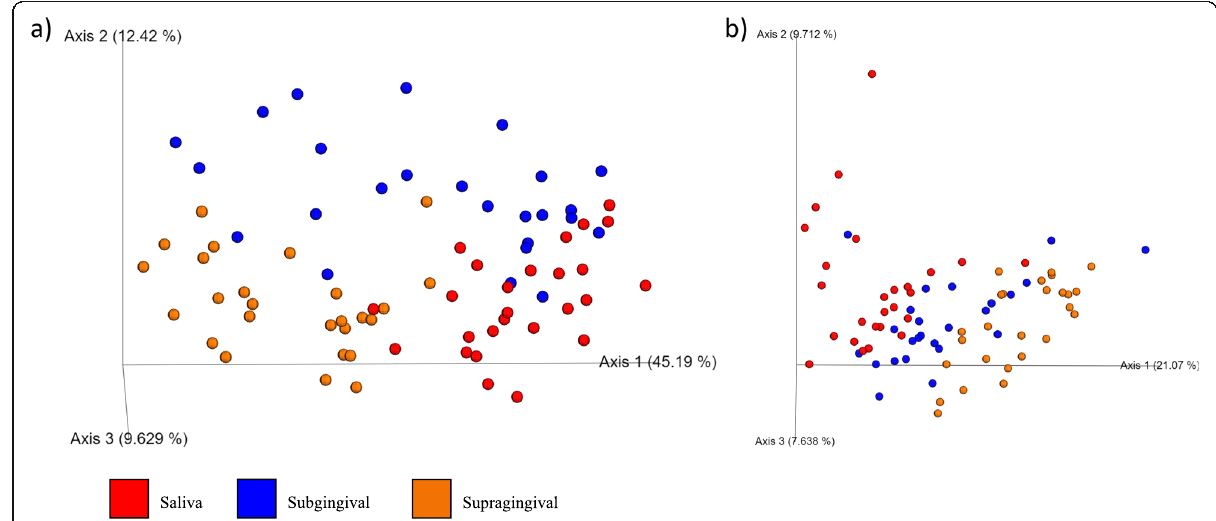
Fig. 2 Principal coordinates analysis (PCoA) plots of weighted ( a ) and unweighted ( b ) UniFrac distances of oral microbial communities performed on the 97% OTU abundance matrix using